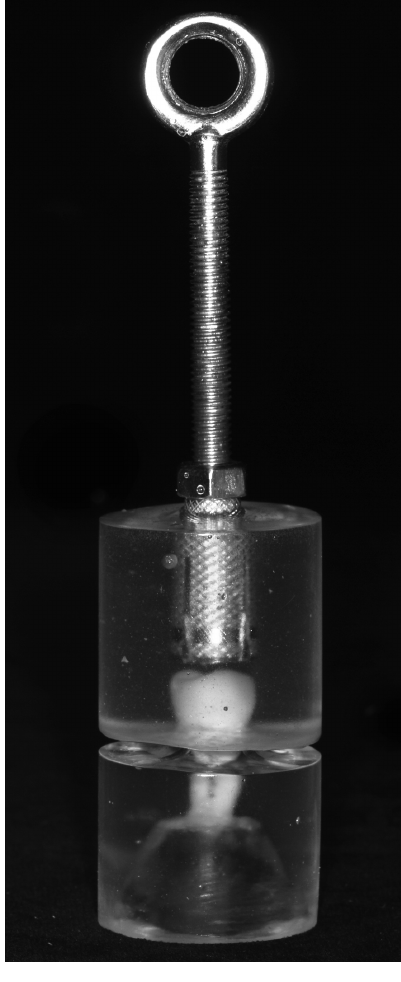
Figure 2. Specimen ready to be